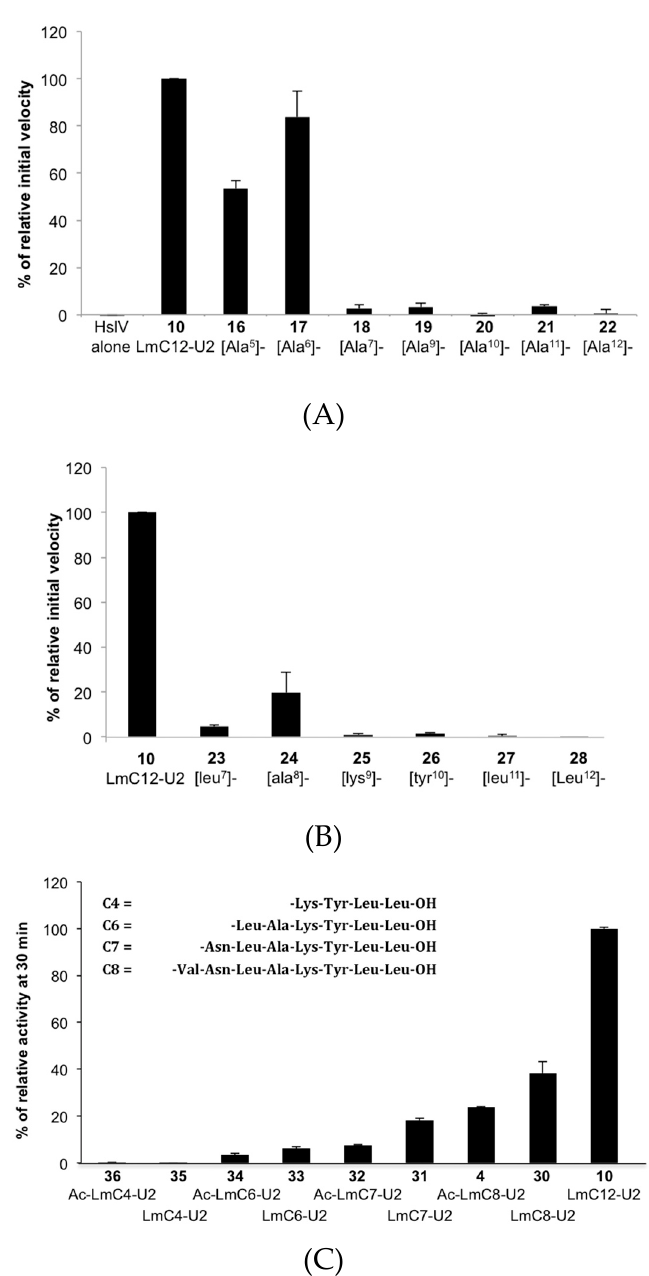
Figure 4. Sequence requirements for activation of LmHslV by C-terminal LmHslU2 peptides. ( A ) Alascan. Percentage of initial velocity relative to compound LmC12-U2. Fluorescence was measured for 30 min incubation at 37 ◦ C of LmHslV (2 µ g) with 100 µ M JMV4482 (Z-EVNL-AMC) in the presence of 500 µ M peptides. ( B ) D-scan. Percentage of initial velocity relative to compound LmC12-U2. Activity was measured as in ( A ). ( C ) Truncated peptides. Percentage of activity relative to compound LmC12-U2, measured as in ( A ).